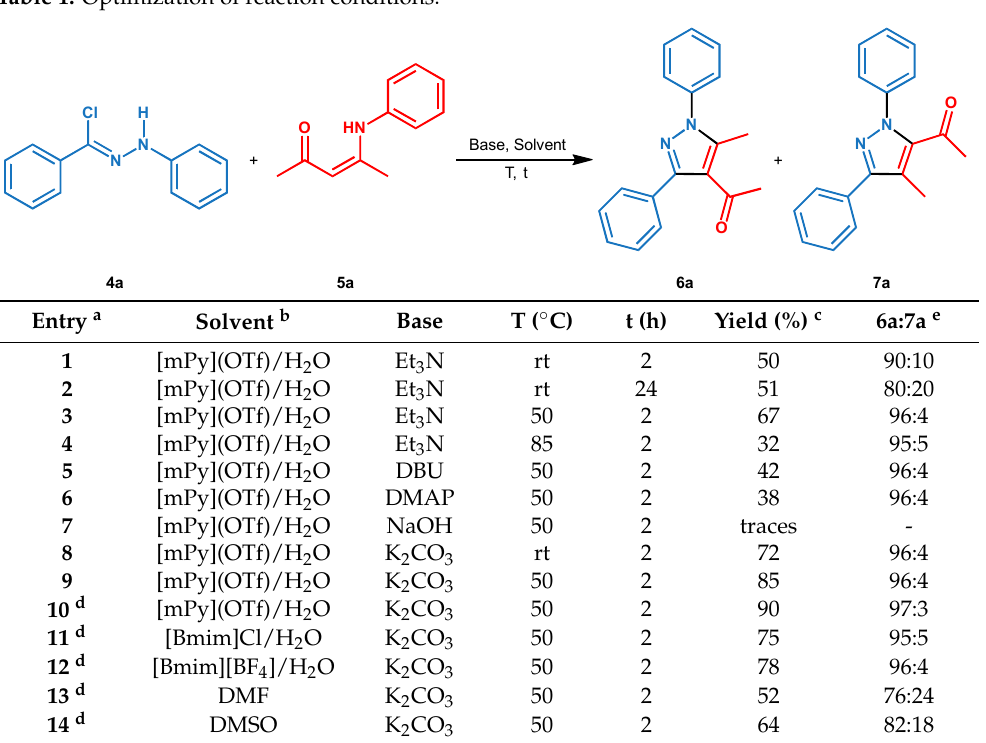
Table 1. Optimization of reaction conditions.